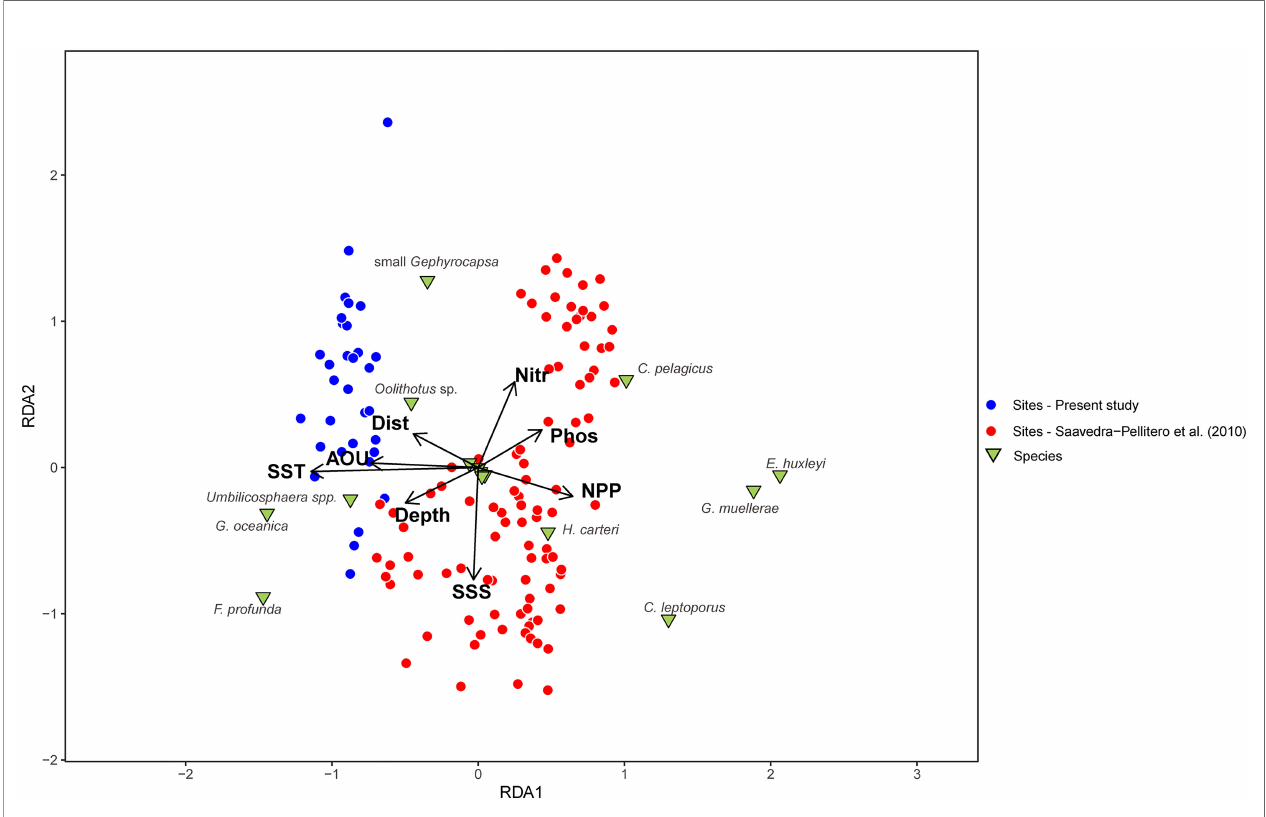
FIGURE 4 | Redundancy Analysis (RDA) biplot showing the sample scores in red (Saavedra-Pellitero et al., 2010) and blue (present study), and the species scores in green. AOU=apparent oxygen utilization, Depth = sample depth, Dist. = distance to the coast, NPP = annual averaged Net Primary Productivity, Nitr = annual averaged nitrate content at 10 m water depth, Phos = annual averaged phosphate content at 10 m, SSS = annual averaged sea surface salinity at 10 m and SST = annual averaged sea surface temperature at 10